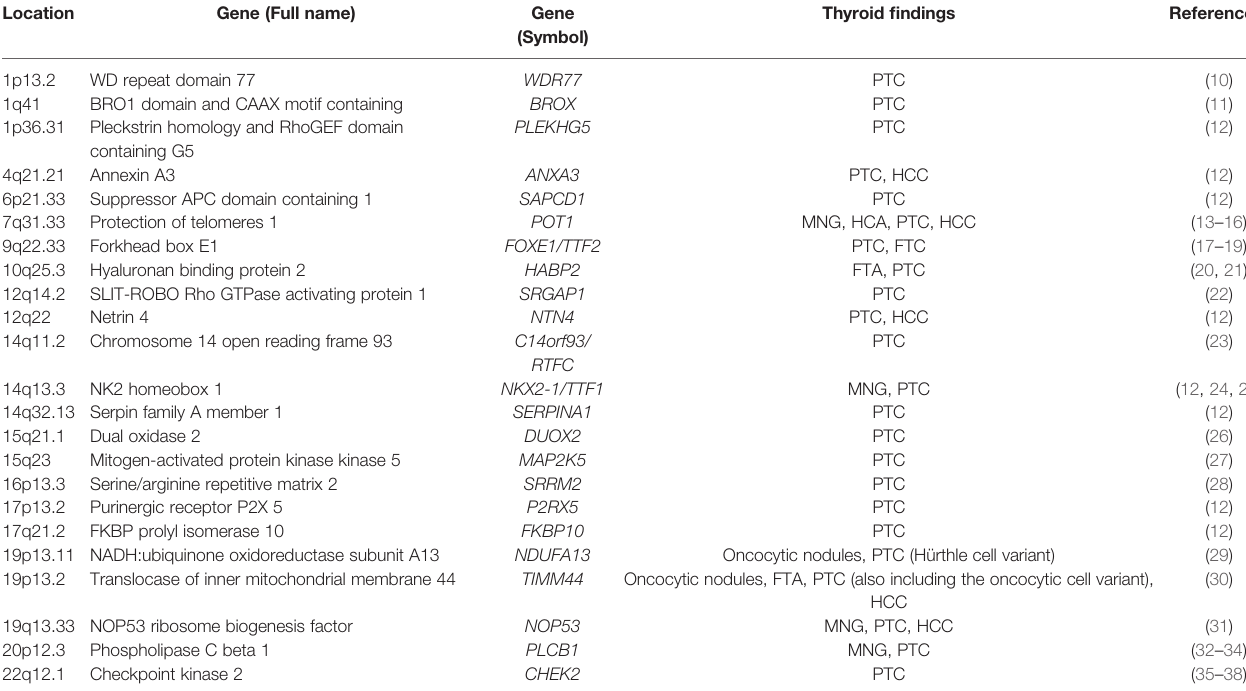
TABLE 1 | Susceptibility genes associated with non-syndromic familial non-medullary thyroid